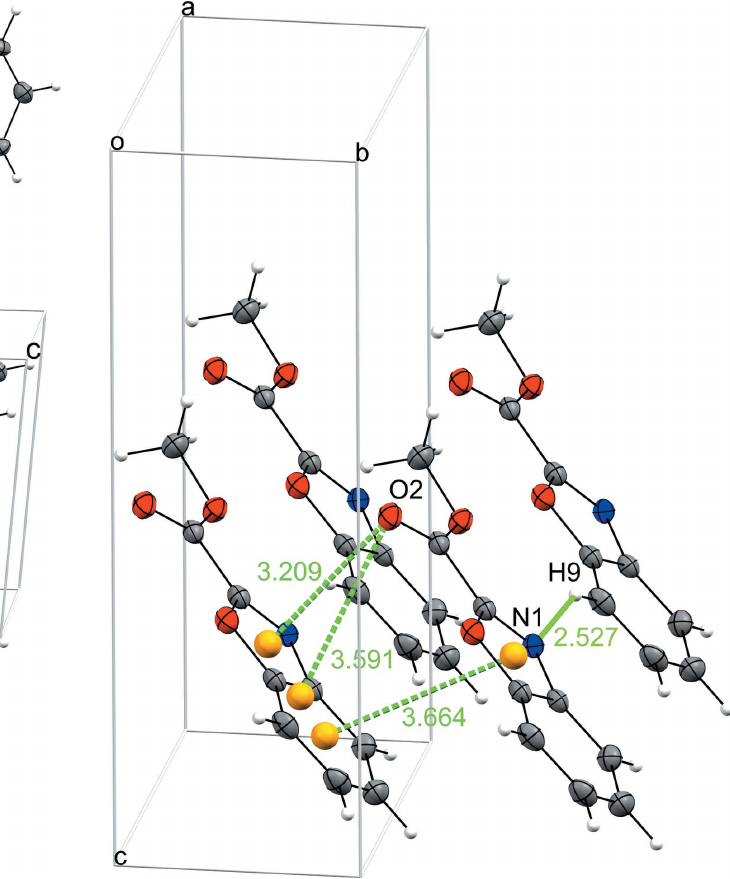
Figure 3 (cid:3) – (cid:3) and C—O (cid:2)(cid:2)(cid:2) (cid:3) interactions (green dotted lines). Orange balls represent the ring centroids Cg